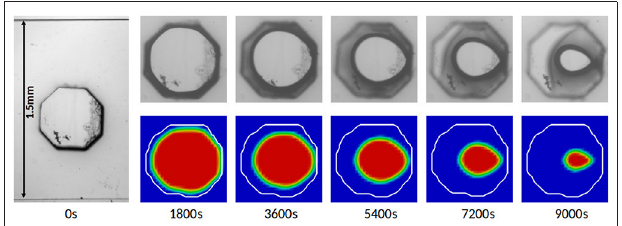
FIGURE 9 | Experimental (top) and computational (bottom) microfluidics images of calcite dissolution process at different time steps during the injection of 0.05% HCl at a mean velocity of 1.16 × 10 − 3 m / s flow rate from the left to the right (Reprinted with permission from Soulaine et al., 2017, Copyright Cambridge University Press 2017).